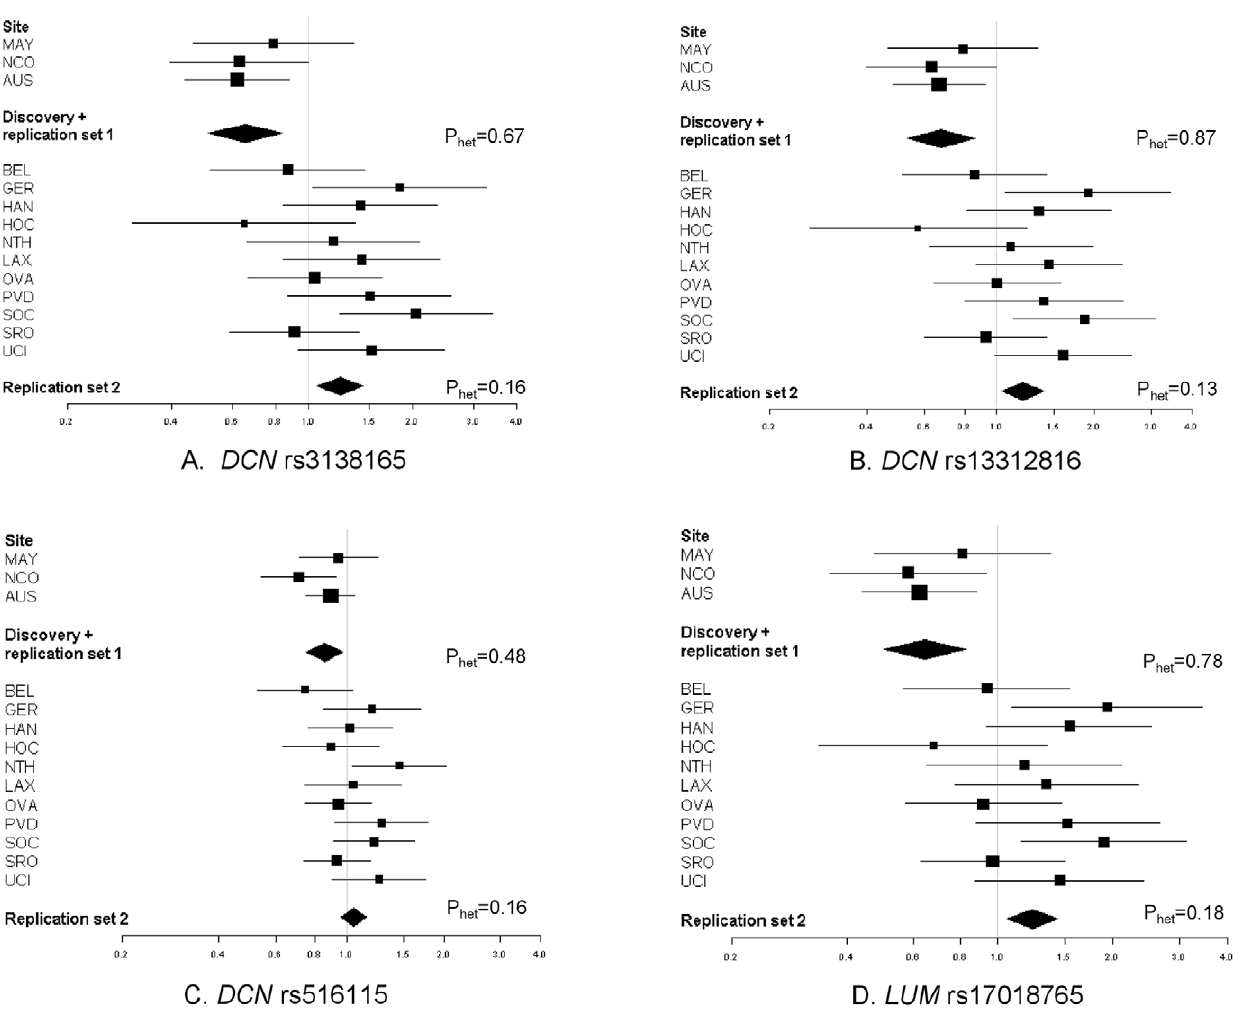
Figure 1. Forest plots for DCN and LUM SNPs and serous epithelial ovarian cancer. Associations represent ORs (95% CI) for the individual study (squares) and study-adjusted pooled (diamonds) estimates. Models are ordinal genetic risk model. HAN-HJO and HAN-HMO were combined for presentation.